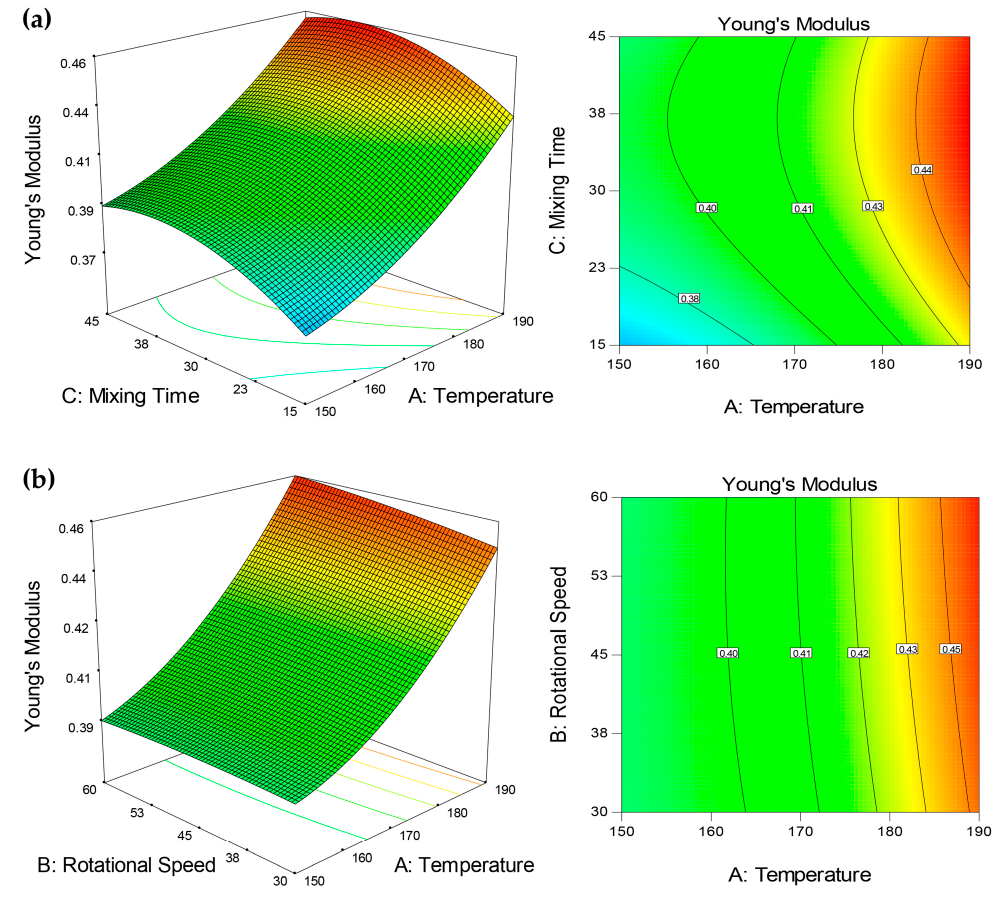
Figure 6. The 3D and contour plot for the dependence of UHMWPE / CNF bionanocomposite’s Young’s modulus on ( a ) temperature and mixing time, and ( b ) temperature and rotational speed as significant factors.